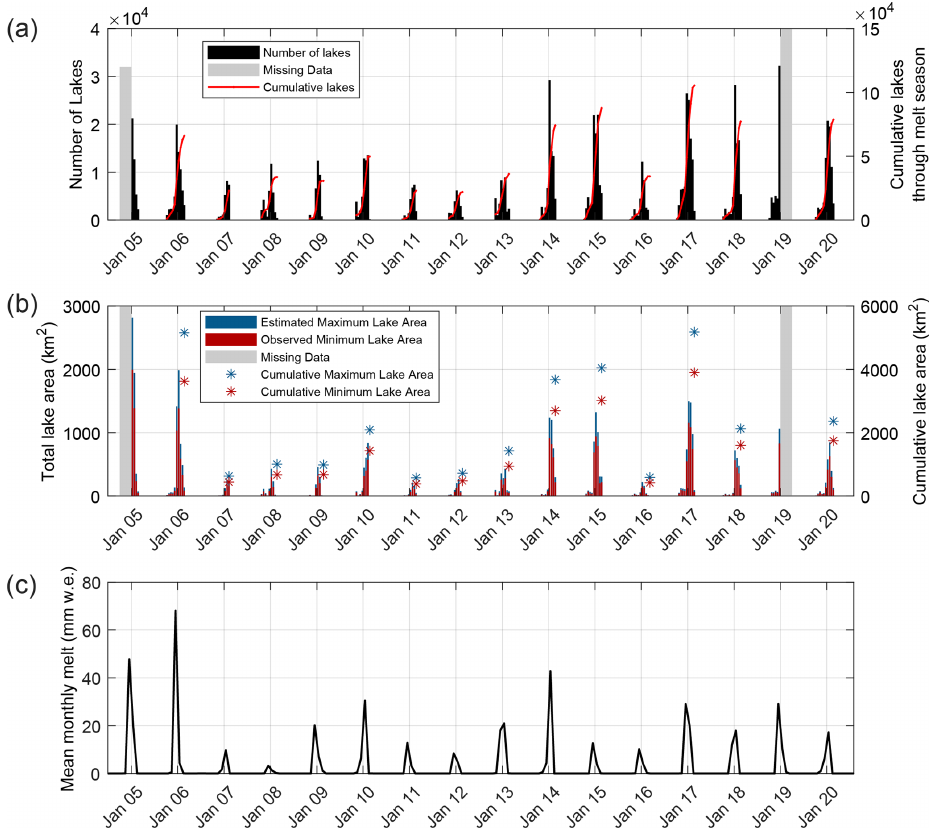
Figure 8. Time series showing the temporal evolution of lakes over the Amery Ice Shelf region between 2005 and 2020. (a) Number of lakes per time window and cumulatively over each melt season. (b) Observed minimum and estimated maximum lake area per time window, in addition to seasonal cumulative totals. (c) Mean monthly modelled melt over the study region, from RACMO2.3p2. Cumulative totals are not included for 2004/05 and 2018/19 due to incomplete data availability over these melt seasons. Note that lake number totals prior to 2013 may be slightly higher than reality, due to large lakes sometimes being “dissected” by SLC striping associated with Landsat 7 imagery. However, the spacing of the SLC stripes, the average size of lakes and the scale of lake numbers involved mean that such overestimates will have been negligible. It was therefore deemed unnecessary to try to account for this in lake number totals. Separate plots of lake areas and RACMO2.3p2 melt estimates for each melt season are shown in Fig. S8 in the Supplement, enabling seasonal variations to be more clearly